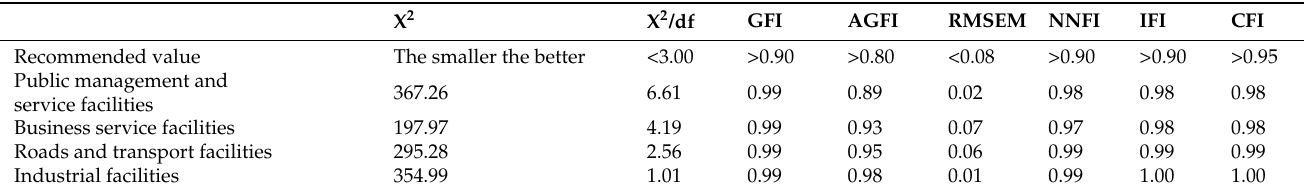
Table 2. Appropriate indicator values for the structural equation